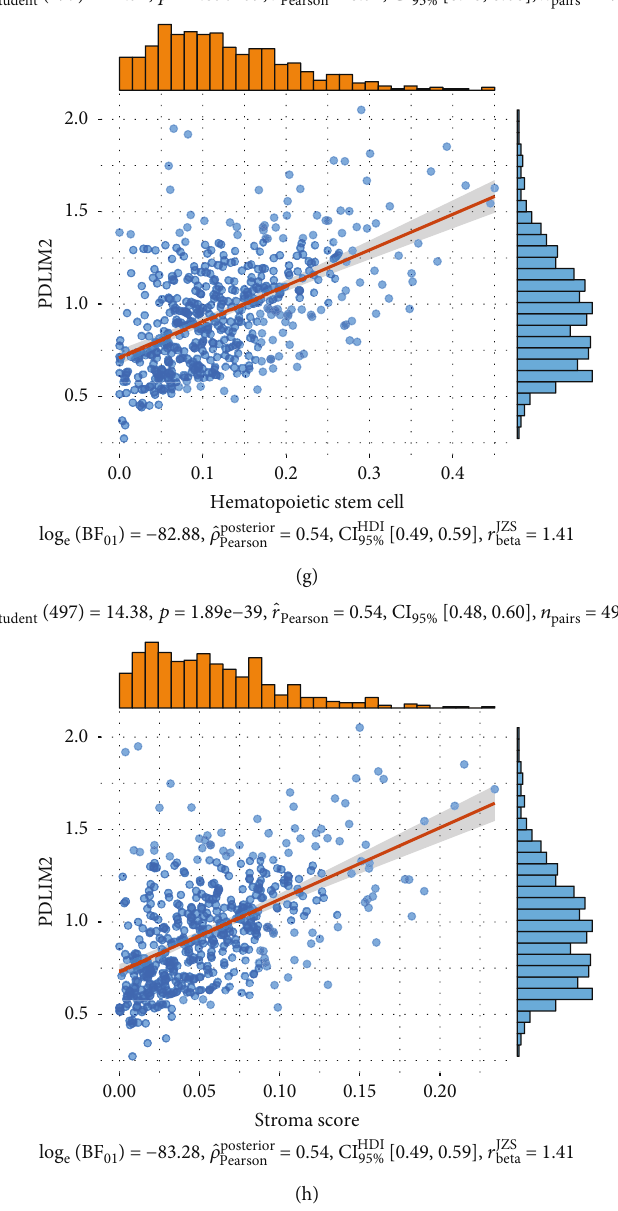
Figure 7: PDLIM2 mRNA was involved in immune in fi ltration in patients with prostate cancer. (a) The mRNA expression level of PDLIM2 was correlated with immune in fi ltration levels in prostate cancer patients. Blue represents a negative correlation; red represents a positive correlation; “ × ” represents no statistical signi fi cance. (b) The relationship between PDLIM2 mRNA expression and MMR genes. (c) Relationships between PDLIM2 mRNA expression and immune checkpoints. (d – h) Spearman ’ s correlation analysis showed the correlation between PDLIM2 mRNA expression and microenvironment score, cancer-associated fi broblast, immune score, hematopoietic stem cell, and stroma score. ∗ P < 0 : 05 , ∗∗ P < 0 : 01 , and ∗∗∗ P < 0 : 0001